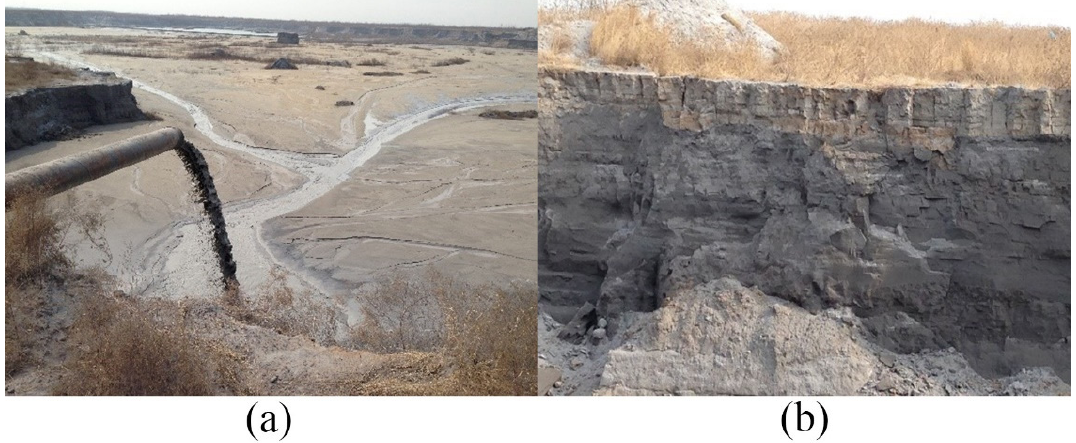
Figure 1. ( a ) Wet fly ash discharge site; ( b ) fly ash storage yard.